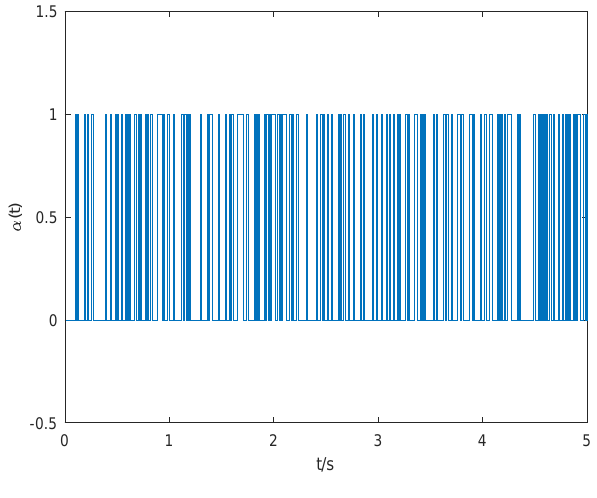
Figure 4. The evolution of α ( t ) .